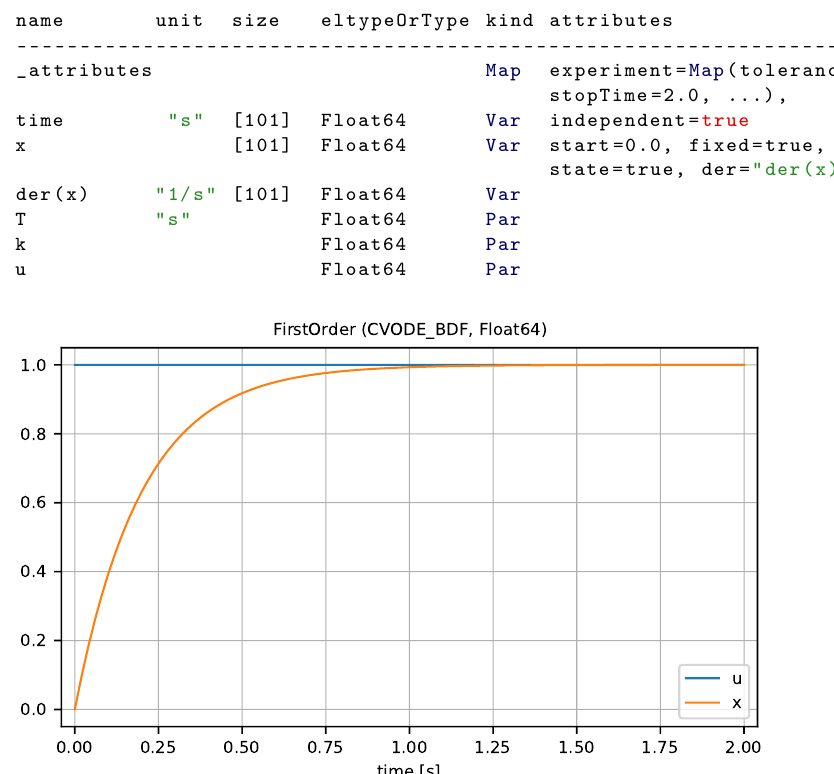
Figure 4. Simulation result of one simulation with T = 0.2, k = 1.0, u ( t ) = 1.0, and x 0 =